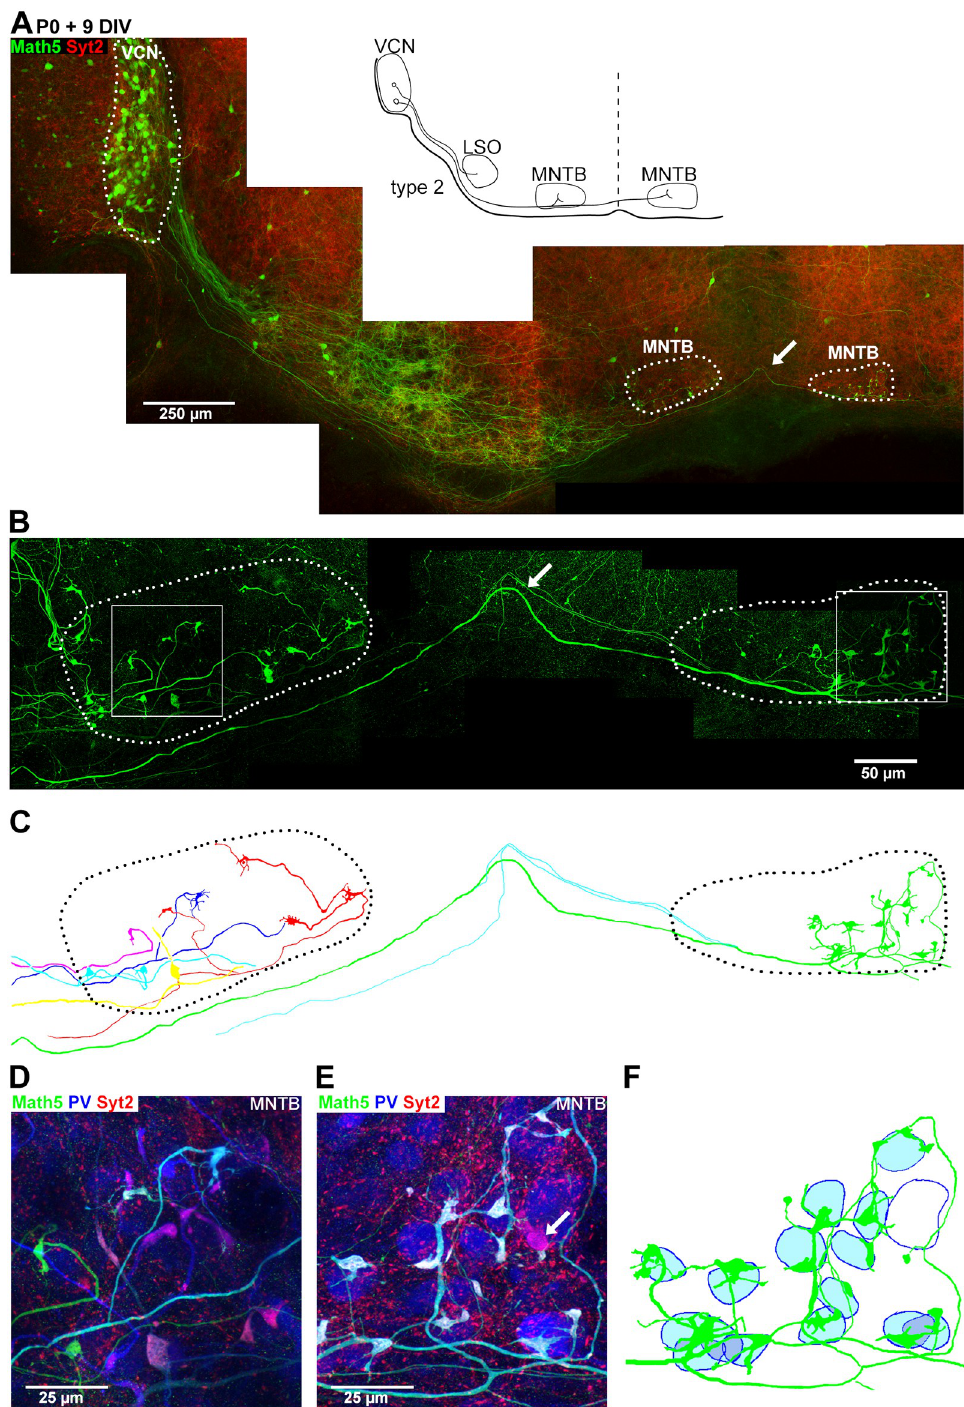
Fig 4. Example of a type 2 organotypic culture with preservedipsi- and contralateral VCN-MNTB circuit. A , Overview of a type 2 slice preparedwith 15˚ slicing angle from a Math5 Cre x Brainbow mouse at P0. The organotypic slice was fixed after 9 days in-vitro and stainedwith an anti-GFP-antibody (green channel),anti-PV antibody (blue channel),and an anti-Syt2-antibody(red channel). The arrow indicatesa midline-crossing axon. B , Maximal intensity projection image (35 images; z step 0.5 μ m) of the ipsilateralMNTB, midlineregionand contralateral MNTB for the GFP channel. Note the presence of Math5—positive axons which elaboratelarge nerve terminals. C , Reconstruction of n = 5 ipsilateralaxons (shown in red, blue, light blue, yellow, and pink),